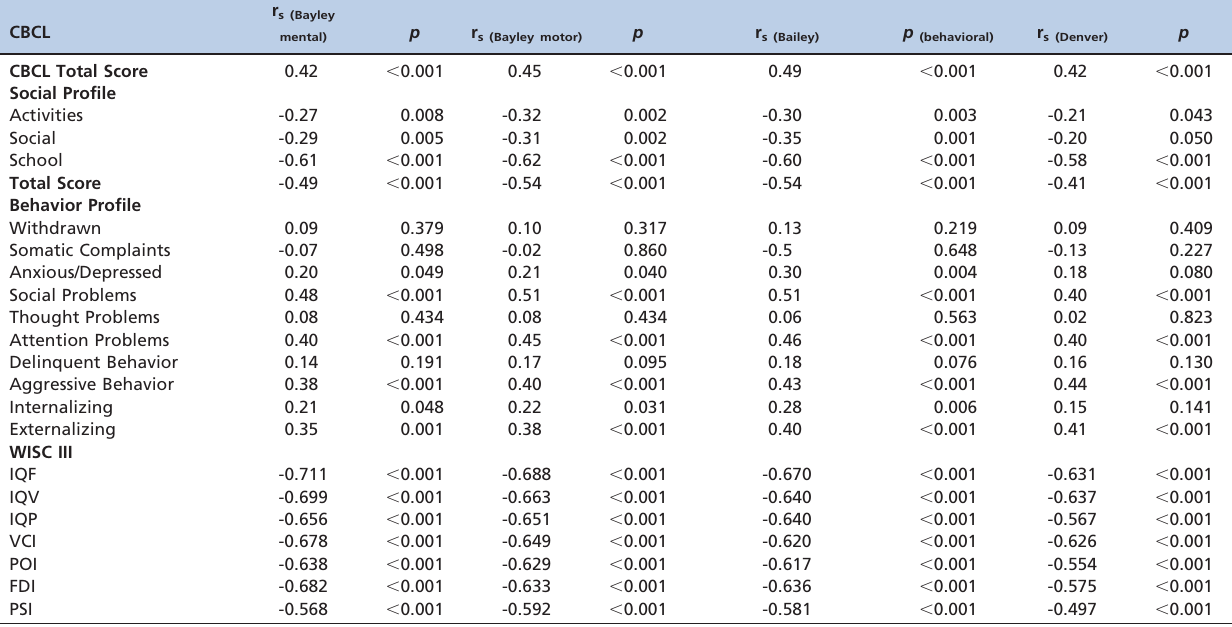
Table 5 - Correlation between the results previously obtained on the Bayley Scales and Denver Test II and the different domains of the Child Behavior Checklist (CBCL) and WISC